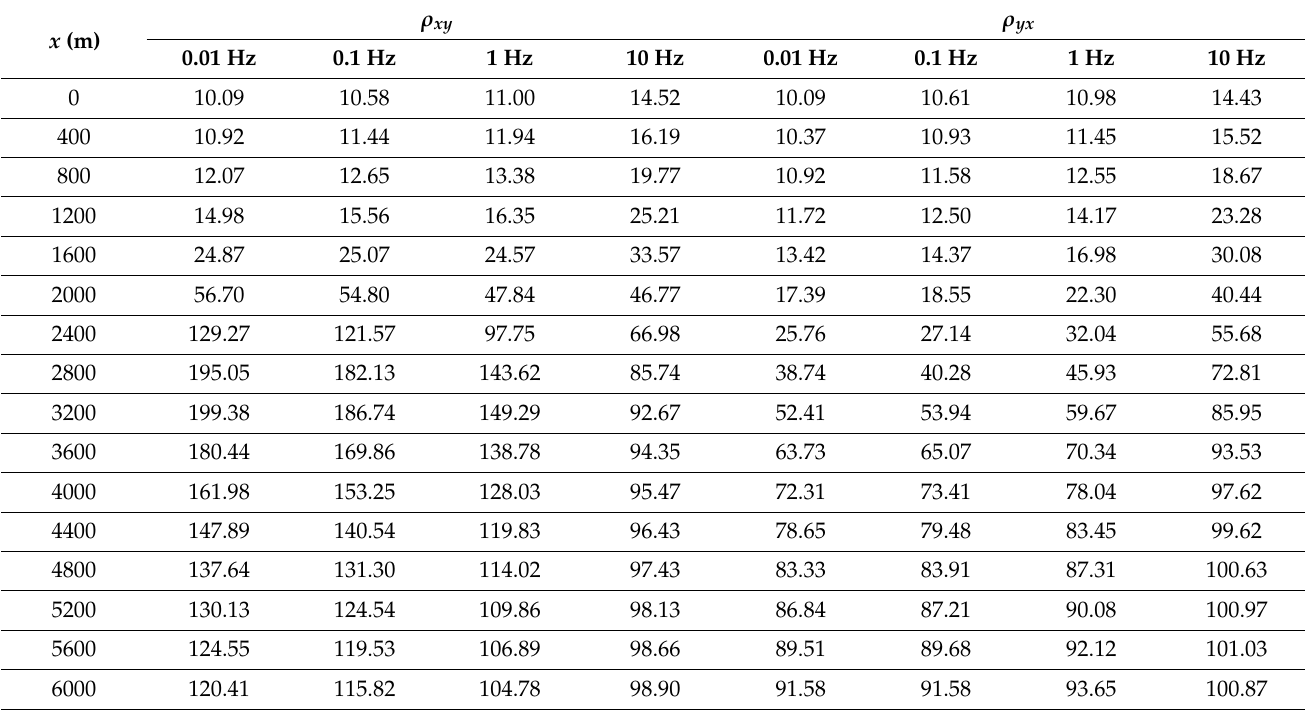
Table 4. The apparent resistivities calculated by the FE method for Model 1, as shown in Table 3. The apparent resistivity unit is Ω m. The y -coordinate is 0